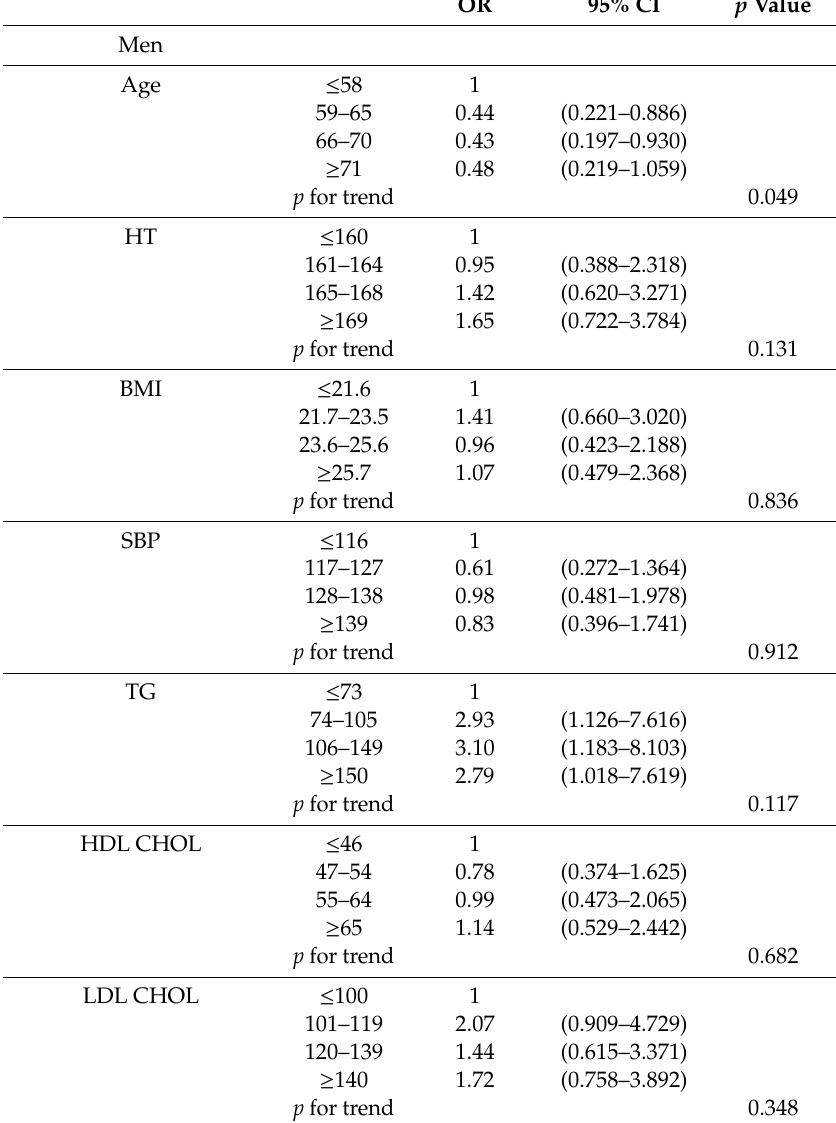
Table 2. Multivariate logistic regression analysis to identify factors associated with high